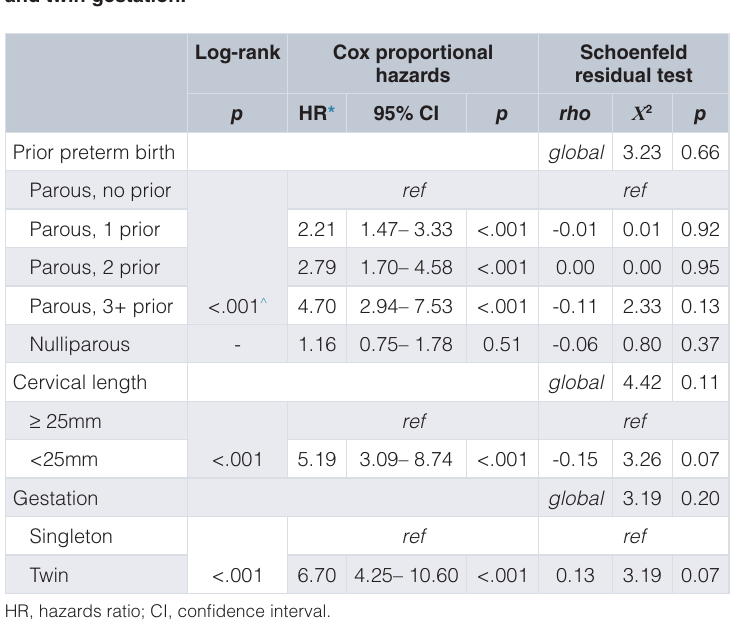
Table 5. Log-rank and Cox proportional hazards regression with test of proportionality assumption for prior preterm birth, short cervical length, and twin gestation.